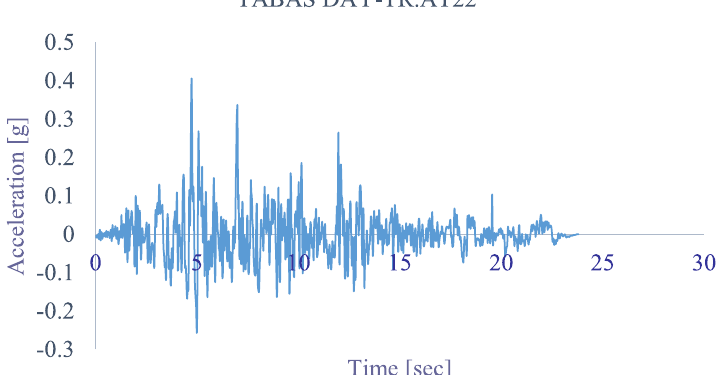
Fig. 9 The other record of the horizontal component (DAY‑TR) of the Tabas